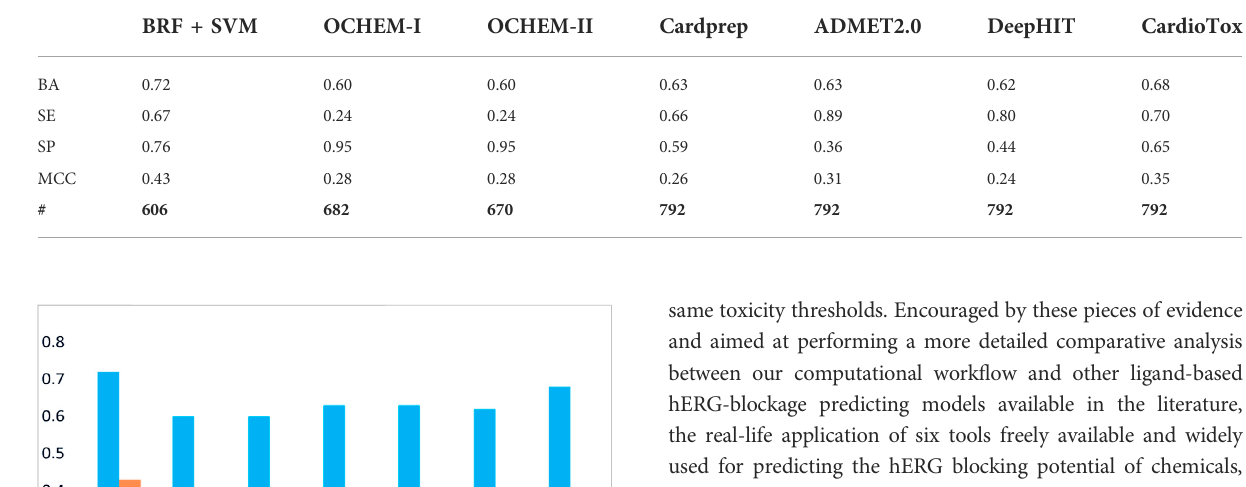
TABLE 4 Comparison in terms of performance on the ES (temporal validation) of the best performing model presented in this study (BRF + SVM) and different classi fi ers available in the literature. The following statistics are reported: balanced accuracy (BA), sensitivity (SE), speci fi city (SPE), Matthews correlation coef fi cient (MCC), and the total number of molecules (#).